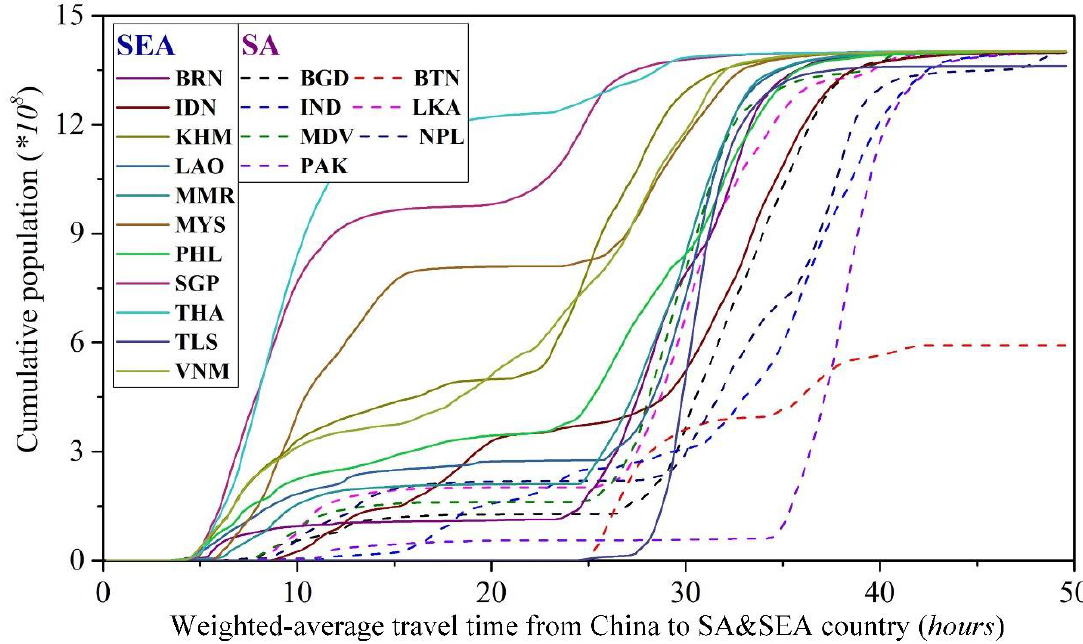
Figure 7. Cumulative population curve on weighted-average travel time from China to each SA&SEA country.